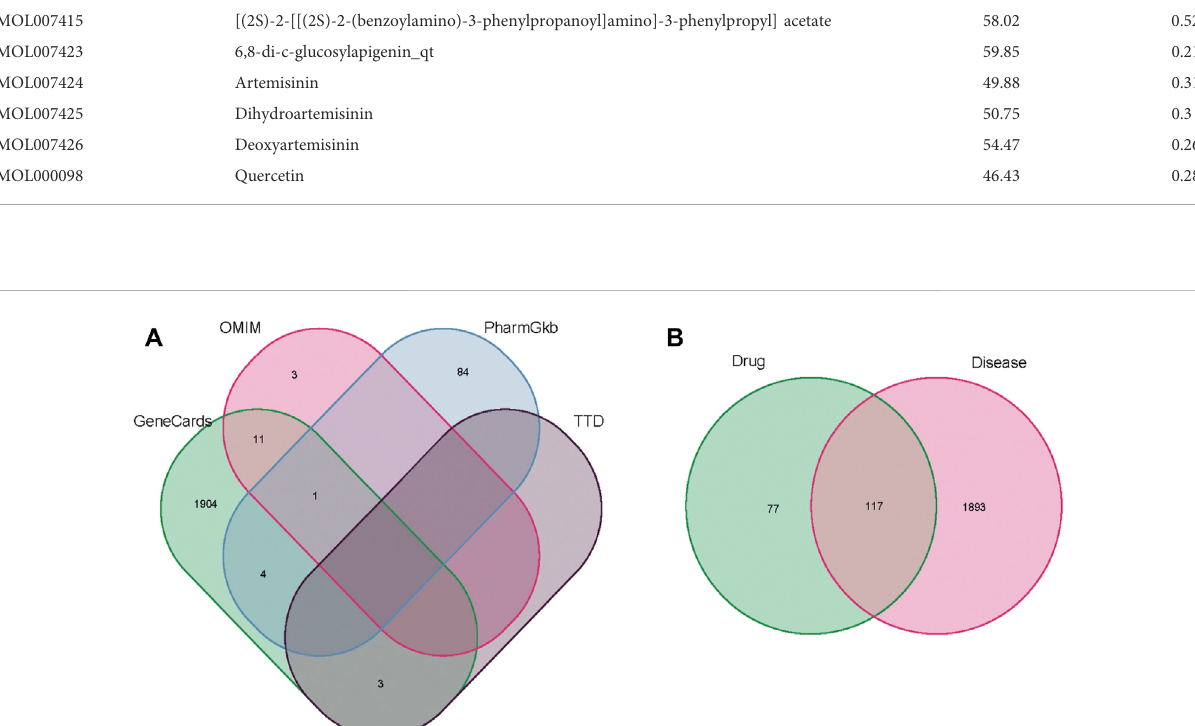
were shown in Figure 3. The horizontal coordinate indicated the proportion of GO entries, the vertical coordinate representing the name of the enriched entry, and the size of the scatter points